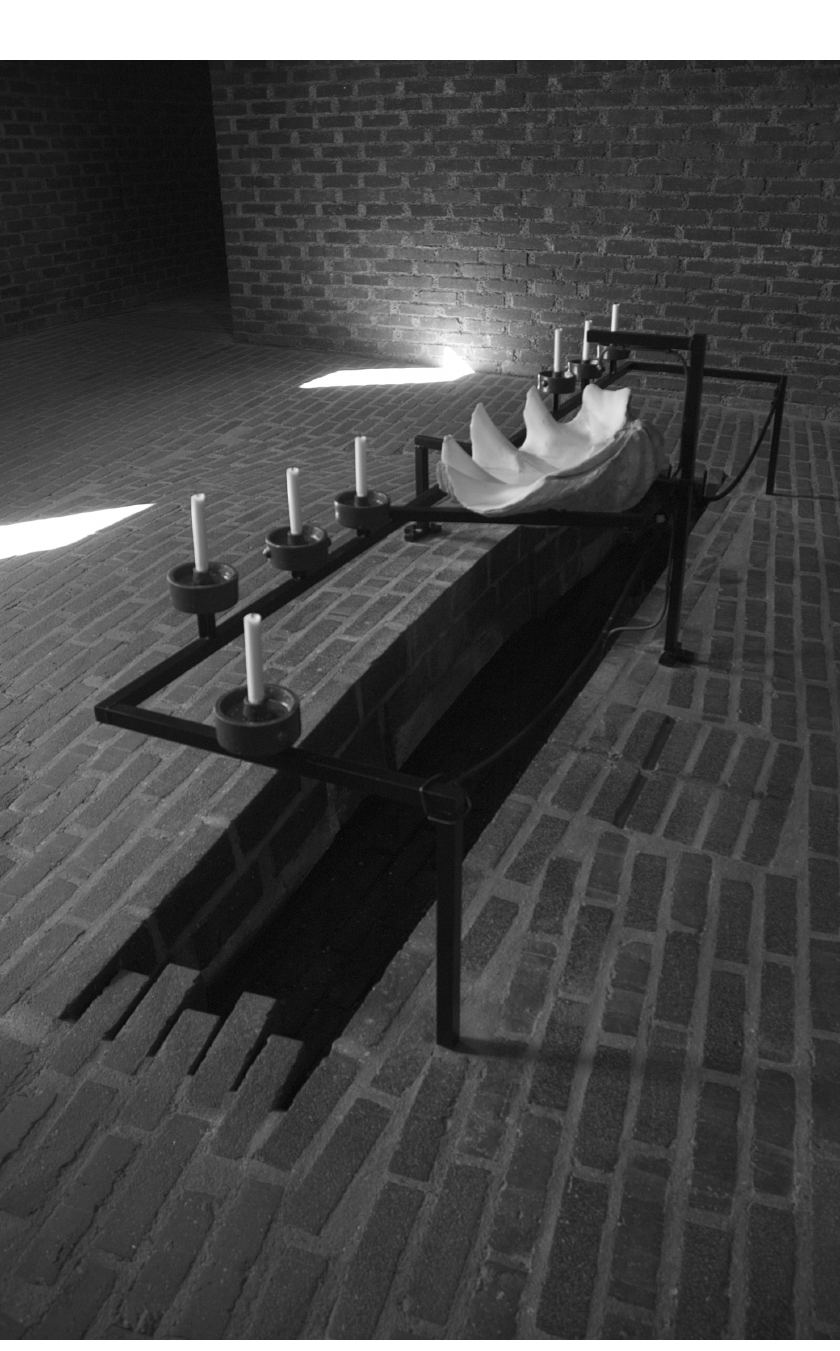
Figure 7: ‘where the language of water and brick poetically coincide.’ (p.